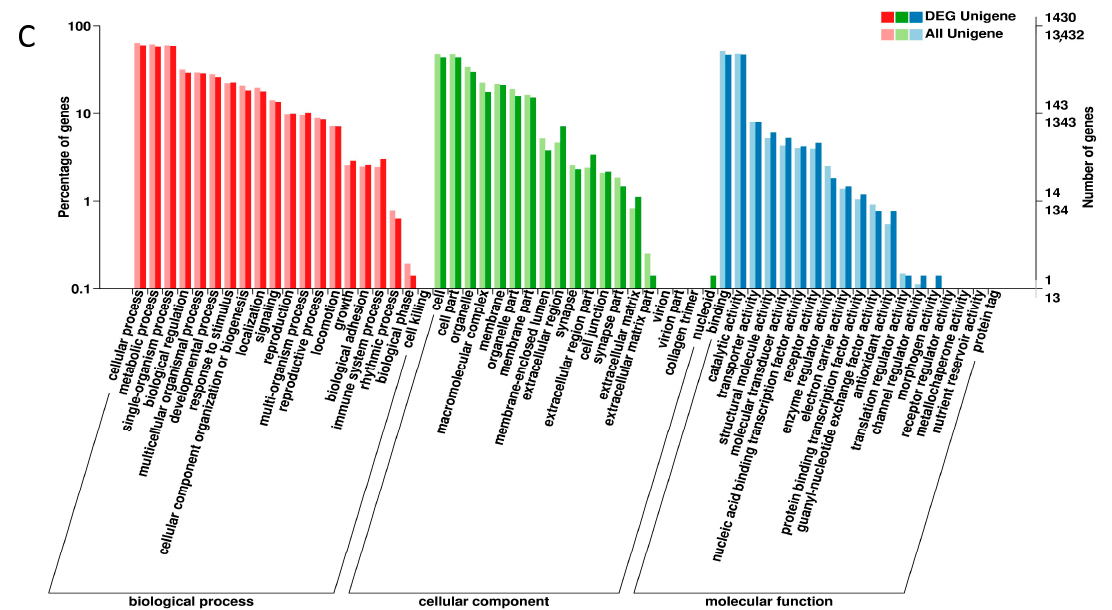
Figure 2. Gene ontology (GO) assignment for the B. dorsalis and B. correcta unigenes. The abscissa shows the GO content. The ordinate on the left is the percentage of the number of genes, while that on the right is the number of genes. The graphs represent both the number of all unigenes and that of DEGs in ( A ) larvae; ( B ) females and ( C ) males assigned to each GO term.